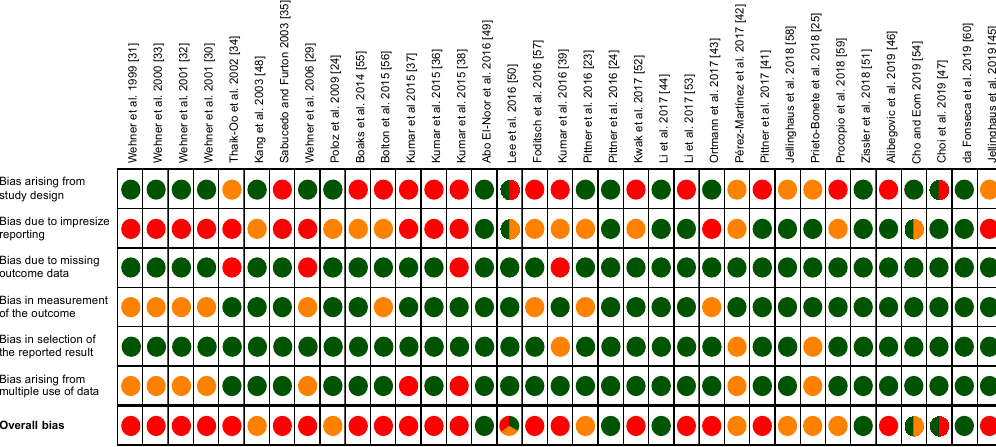
Figure 3. Risk of bias assessment of included studies. Green = low risk of bias, yellow = moderate risk of bias, red = high risk of bias. Mixed colors indicate that parts of the study were assessed with different risks of bias.